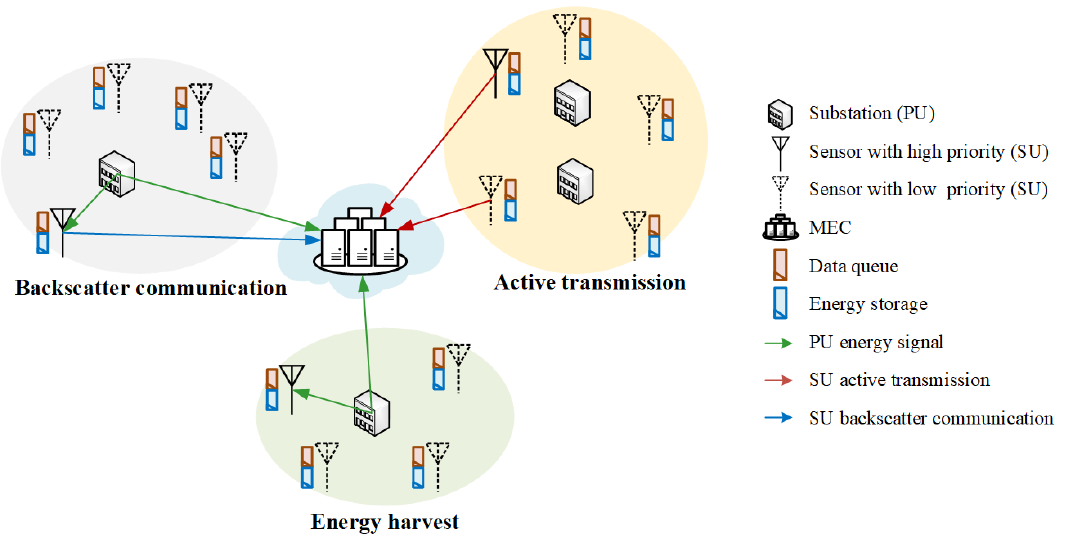
Figure 1. Backscatter communication system